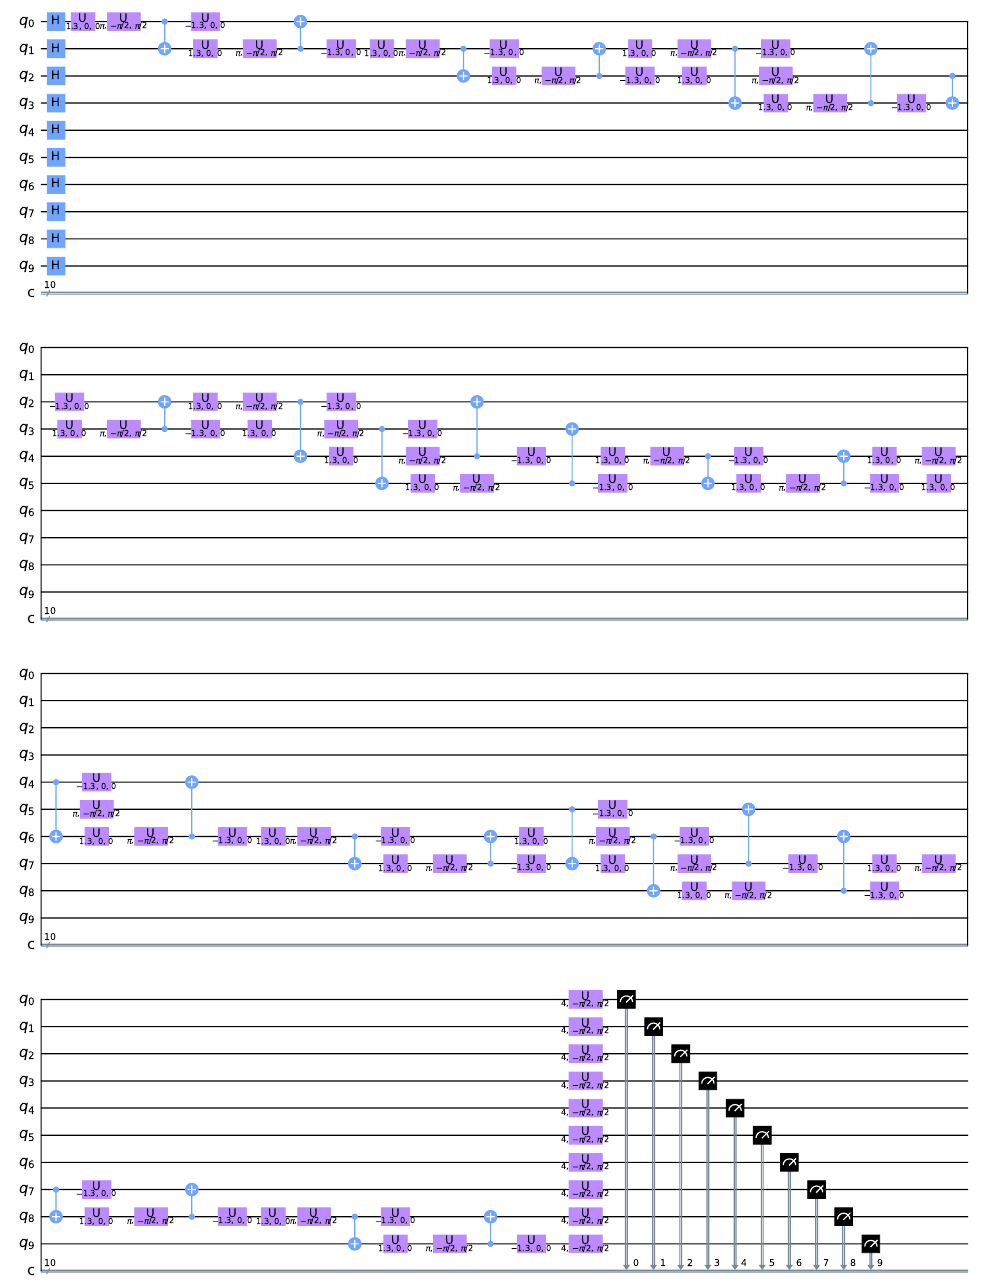
Figure 5. QAOA—Villalba–Diez et